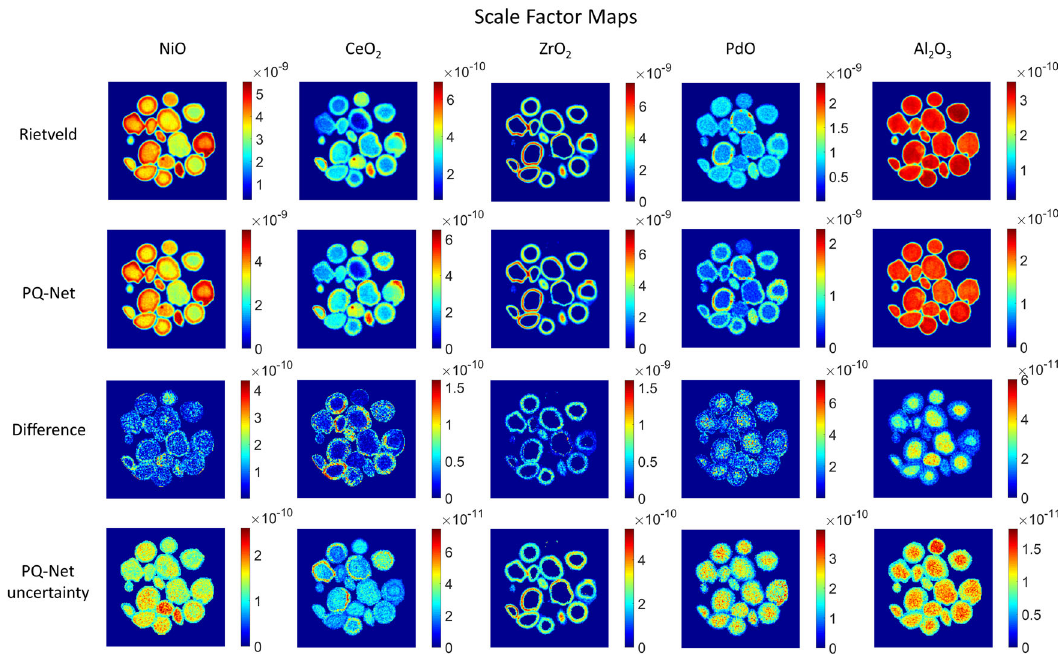
Fig. 5 PQ-Net scale factor results for the multi-phase experimental data. Scale factor maps obtained with the Rietveld method, results obtained with the PQ-Net, their absolute difference for the experimental multi-phase NiO-PdO-CeO 2 -ZrO 2 -Al 2 O 3 system and the uncertainty maps of the deep ensemble PQ-Net (last row).